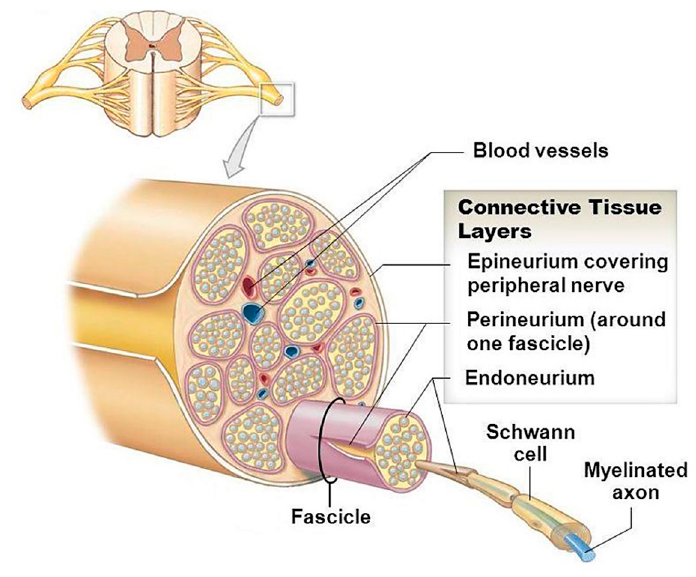
Figure 1. Schematic representation of a peripheral spinal nerve (cross-sectional view) showing its layers and components. Reproduced with permission from ref [31] .